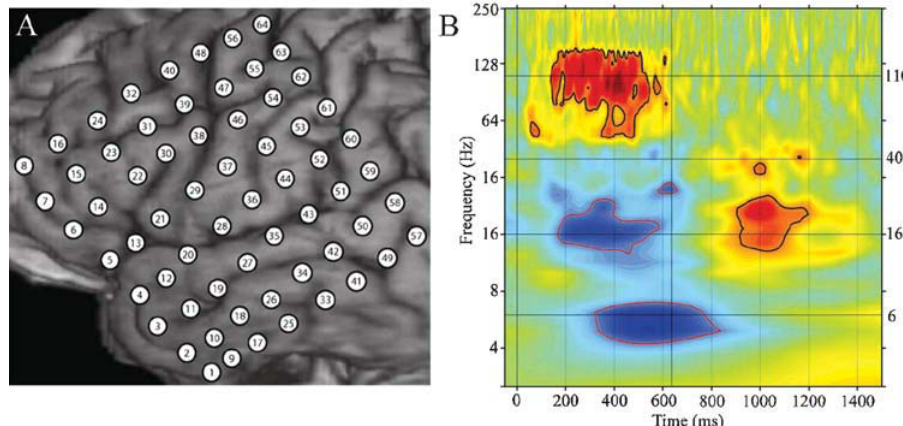
Figure 4. ( A ) Close-up of structural MRI for subject A showing numbered electrode positions (see also Figure1A for same subject). See methods for MNI coordinates. ( B ) Event-related time–frequency plot for ECoG response at electrode 55 (premotor region) following verb presentation. Verb onset (0ms) and offset (637ms) are marked by solid black vertical lines. Black horizontal lines mark frequencies of interest (6, 16, 40, and 110Hz) which are shown in Figure 3. Note strong HG ( ˜ 110Hz, HG) power increase (red), initial beta ( ˜ 16Hz) power decrease (blue) followed by very late beta increase, and late theta ( ˜ 6Hz) power decrease. Outermost black (red) contour line indicates significant power increase (decrease) (p<0.001, FDR corrected).